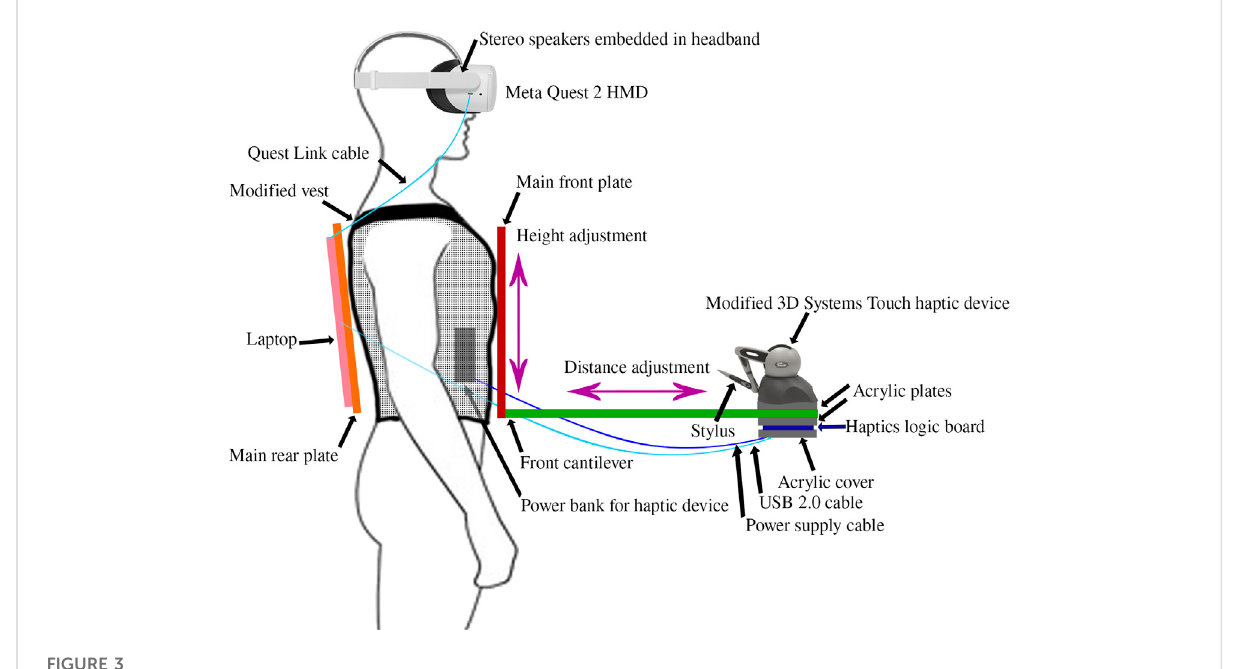
FIGURE 3 Hardware assembly as worn — illustration